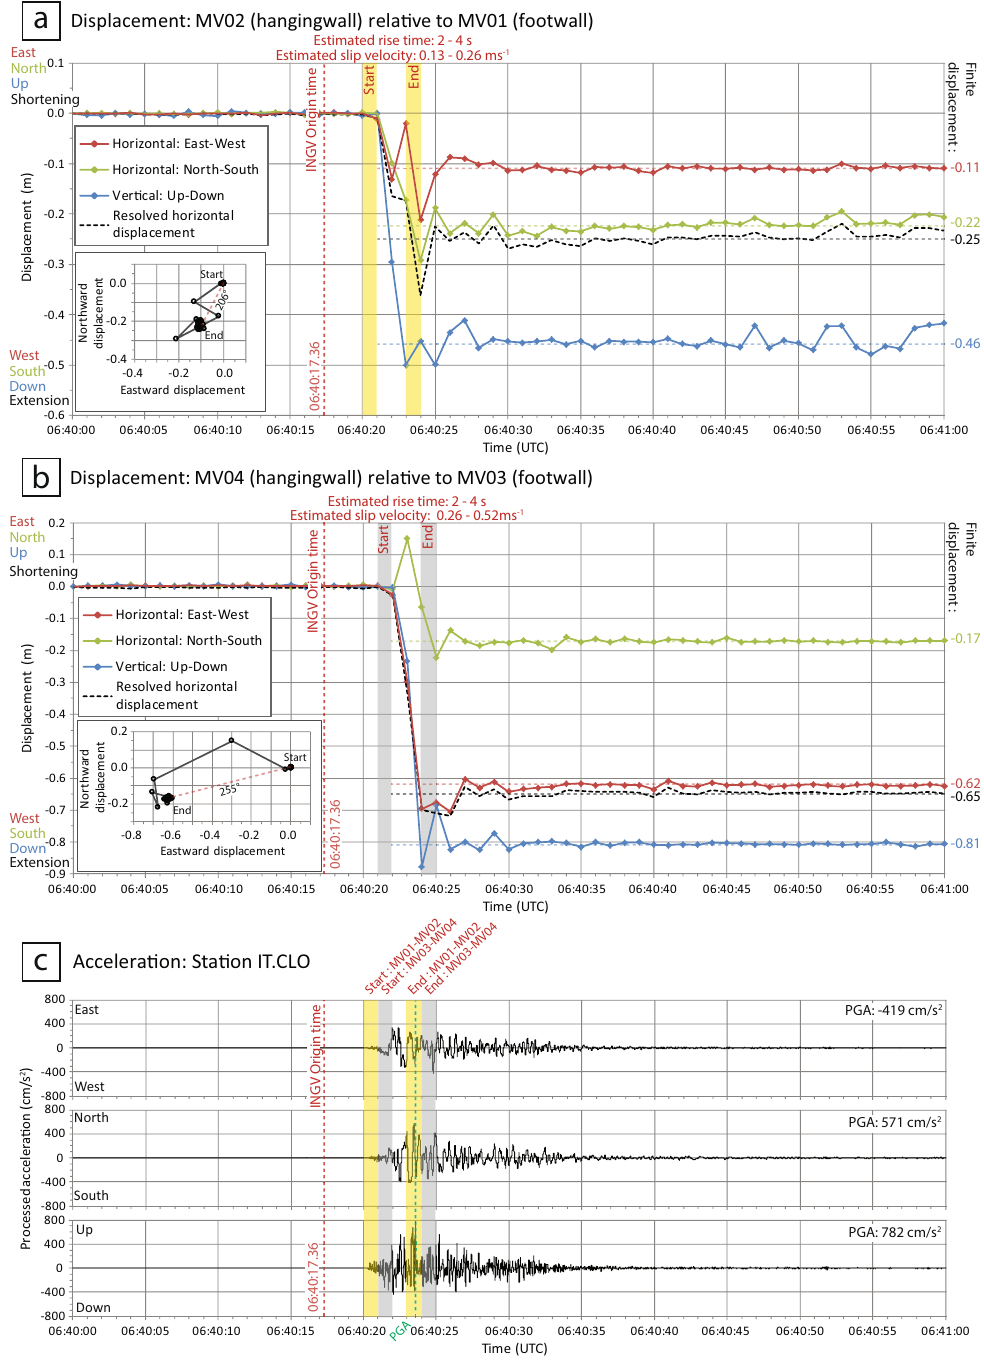
Figure 2. ( a,b ) Time-series of three component relative displacement recorded by GNSS receivers (06:40:00– 06:41:00 UTC; see Fig. 1a for locations). Data points represent calculated positions of the GNSS receiver in the hangingwall relative to its corresponding unit in the footwall, at 1 Hz. The inset plot shows the ground track with time on a horizontal plane. Horizontal dashed lines represent the finite co-seismic displacement of each component estimated from the temporal record. Vertical dashed lines represent key times in the sequence. For each GNSS pair, the start and end of co-seismic displacement is estimated as the time when all three components of displacement first reach their finite co-seismic displacement values. Horizontal and vertical error bars are included but are too small to see. ( c ) Three-component acceleration with time for station IT.CLO of the Italian Strong Motion Network 15 . See Fig. 1a for location of